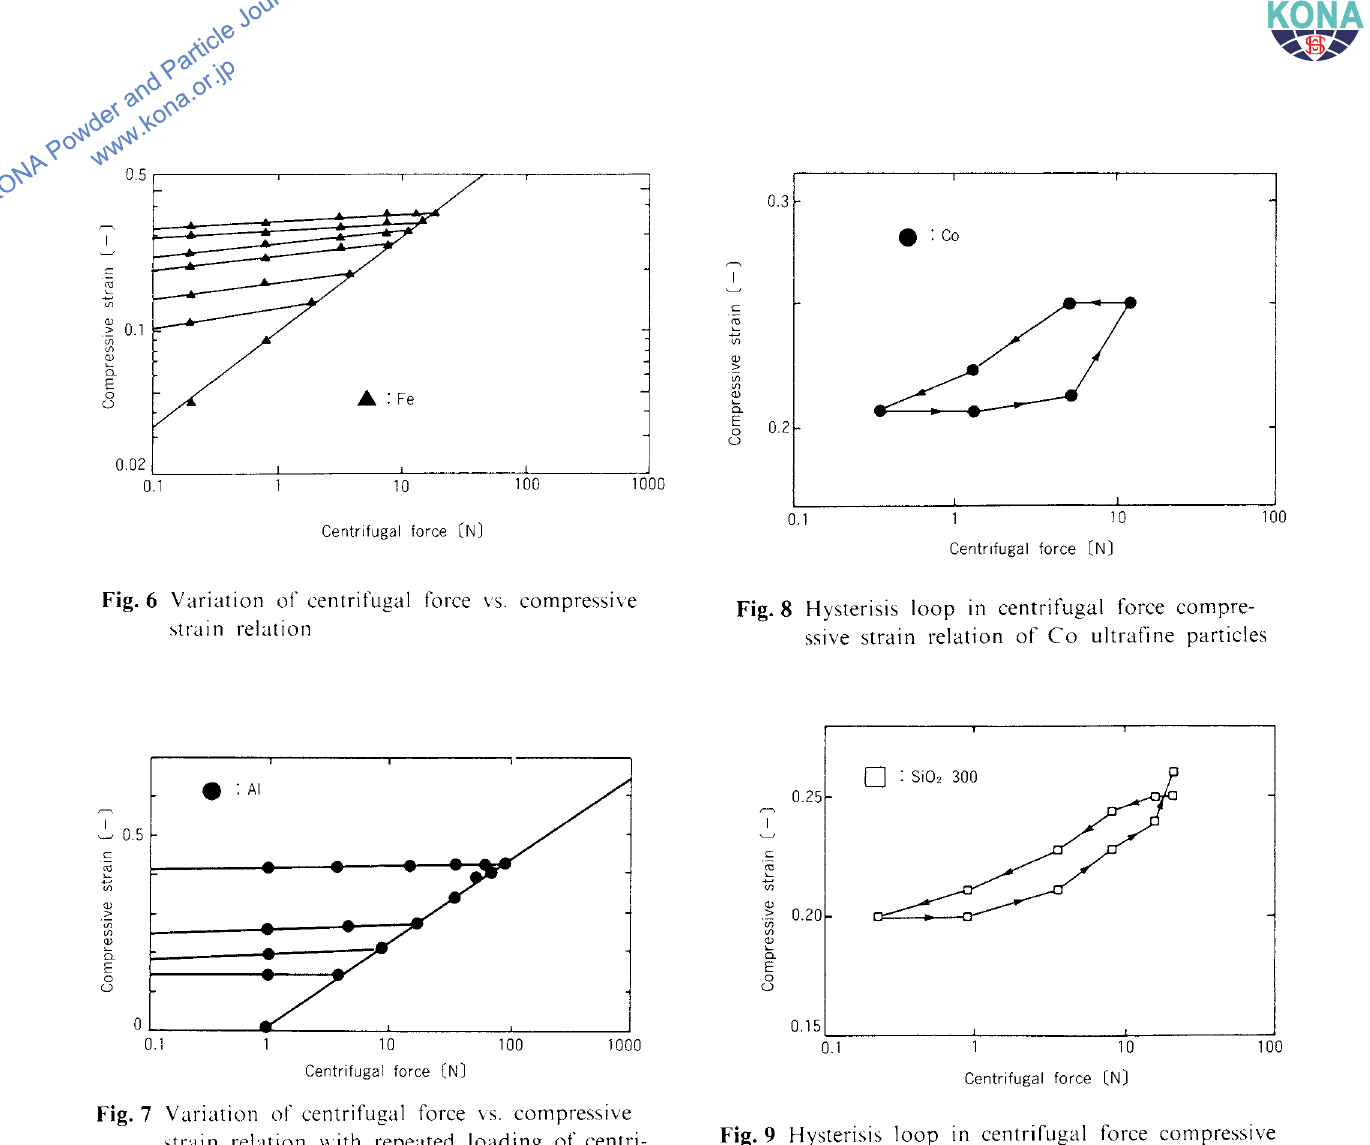
Fig. 9 Hysterisis loop in centrifugal force compressive strain relation of SiOz 300 ultrafine particles